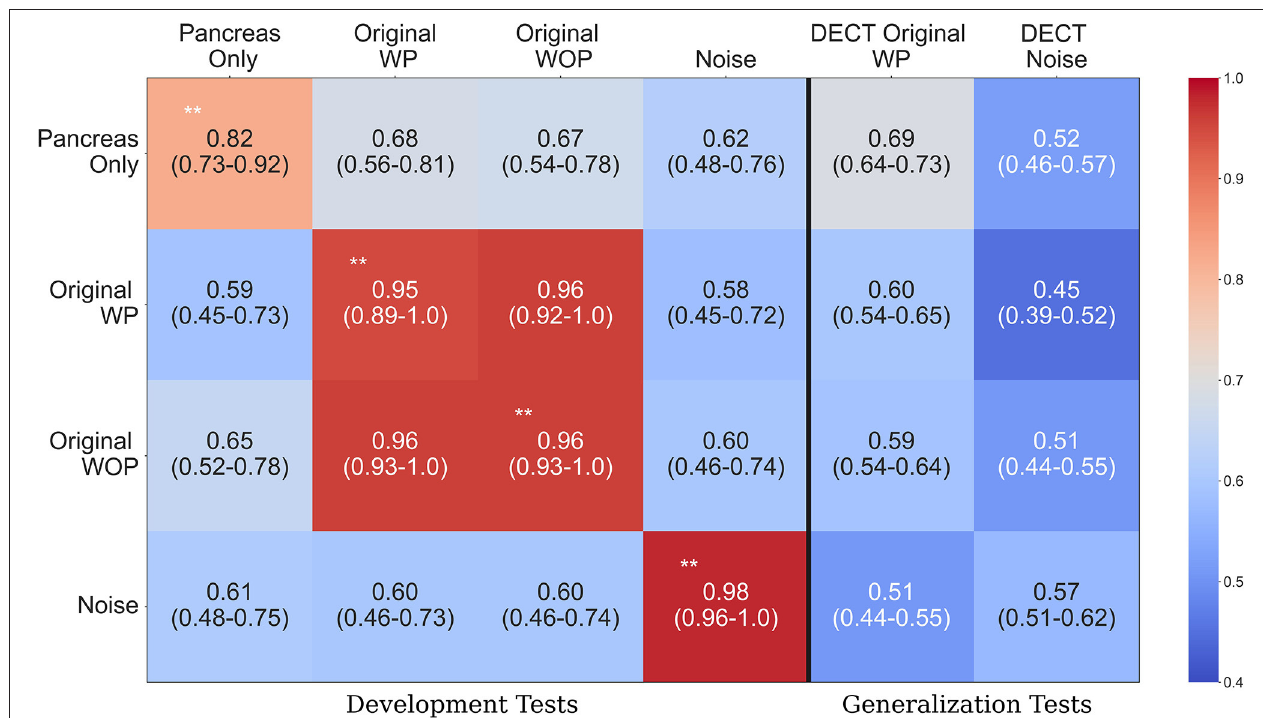
FIGURE 4 | Area under the curve (AUC) heatmap across models for each input format type. Each row indicates the cross-validated mean AUC with 95% confidence intervals for the systems trained with a given input format and evaluated with all other formats from the development dataset (first four columns). The last two columns show the performance of each system on the generalization dataset. The diagonal elements on the development tests correspond to training and testing with the same input format. Red indicates the highest AUC values, while light blue indicates the lowest AUC values. The non-significant difference on the original with pancreas (WP) and without pancreas (WOP) development test sets indicates that spurious correlations drive the performance observed on the self-test sets, instead of features specific to the pancreas or pancreatic cancer. **Development test images processed identically to the data used for training that model. WP, With pancreas; WOP, Without pancreas; DECT, Dual Energy